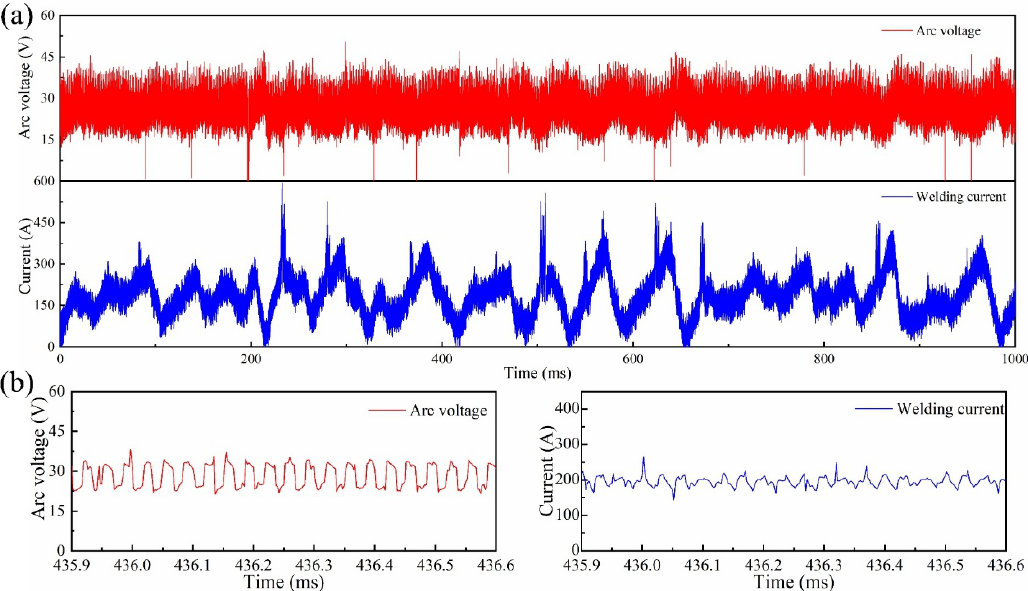
Figure 4. Welding current and arc voltage waveforms of the UFP-UWW process at the excitation parameters of 20 V–30 kHz: ( a ) the overall welding current (blue) and arc voltage (red) waveforms of the UFP-UWW process; ( b ) detailed arc voltage waveform at the time interval between 435.9 and 436.6 ms (red) and detailed welding current waveform at the time interval between 435.9 and 436.6 ms (blue).